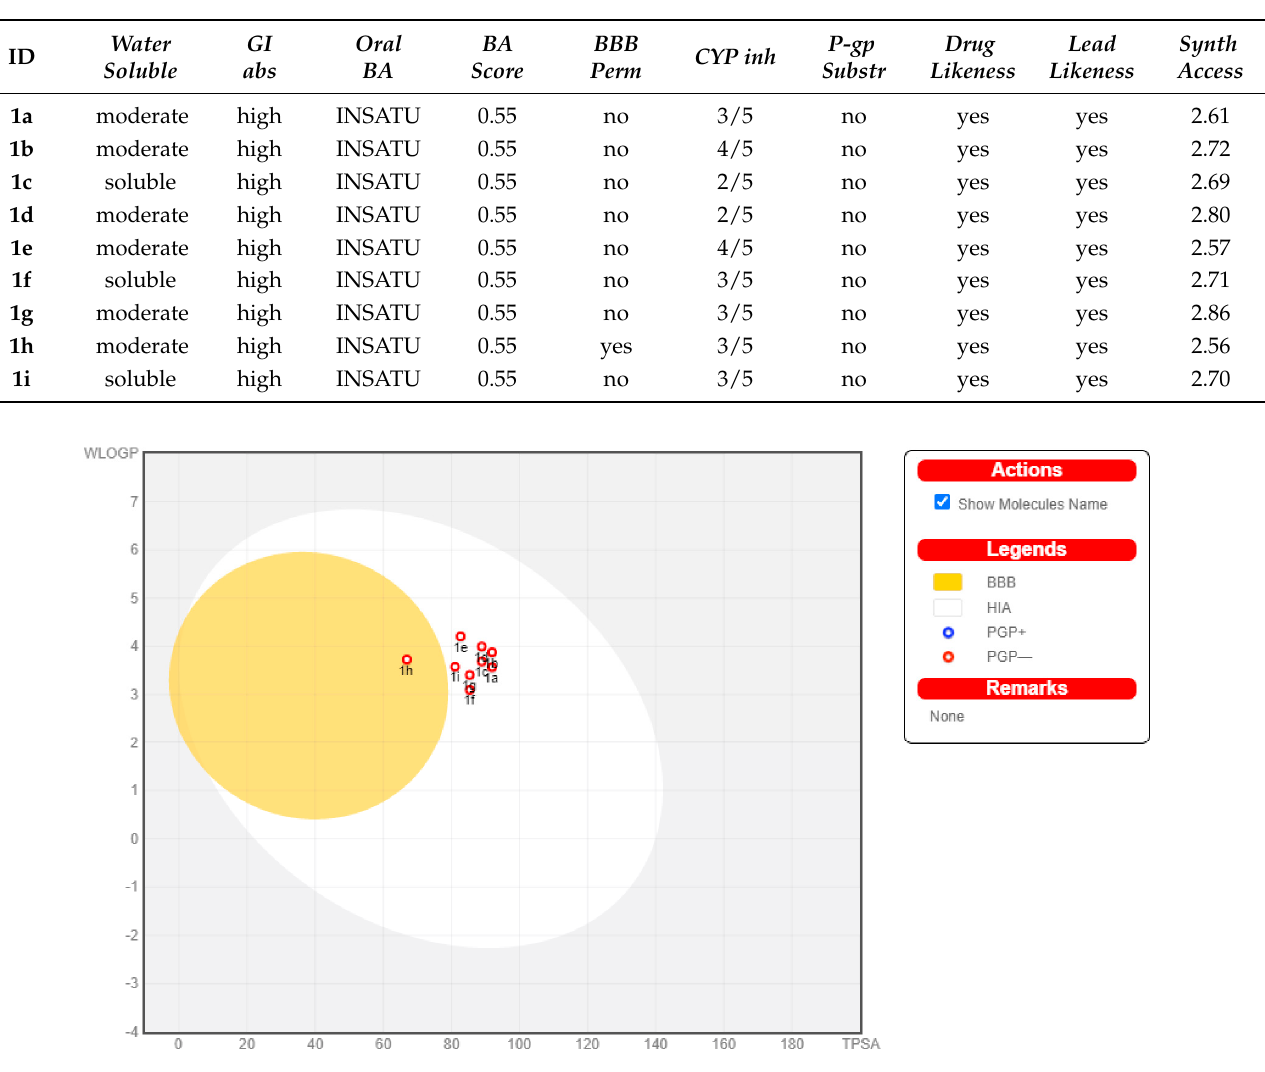
Figure 2. BOILED-Egg diagram for the designed arylsulfonyl hydrazones. Presence in the white area corresponds to good oral permeability, while presence in the yellow area—to BBB permeability. The red circles indicate that the compounds are not substrates of P-gp .